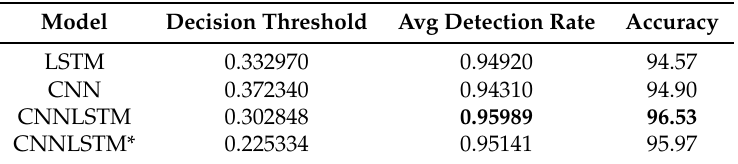
Table 2. Performances according to the models.